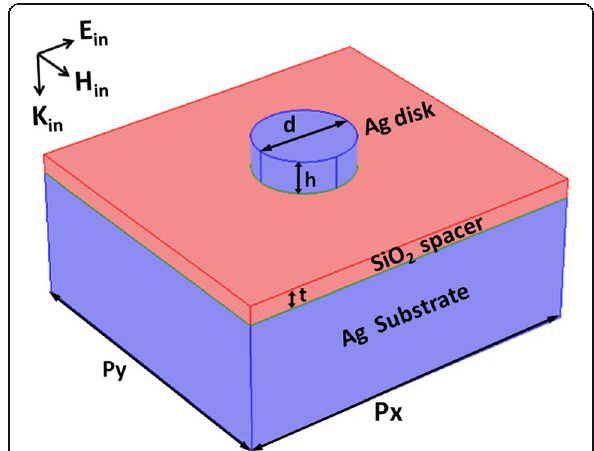
Fig. 1 Schematic of metamaterials composed of Ag nanodisks and a SiO 2 spacer on Ag substrate. Geometrical parameters: p x and p y are the array periods along the x and y directions, respectively; t is the thickness of the SiO 2 spacer; d and h are the diameter and the height of the Ag nanodisks. E H K in , in , and in are the electric field, magnetic field, and wave vector of the incident light, which are along the x , y , and z axes, respectively